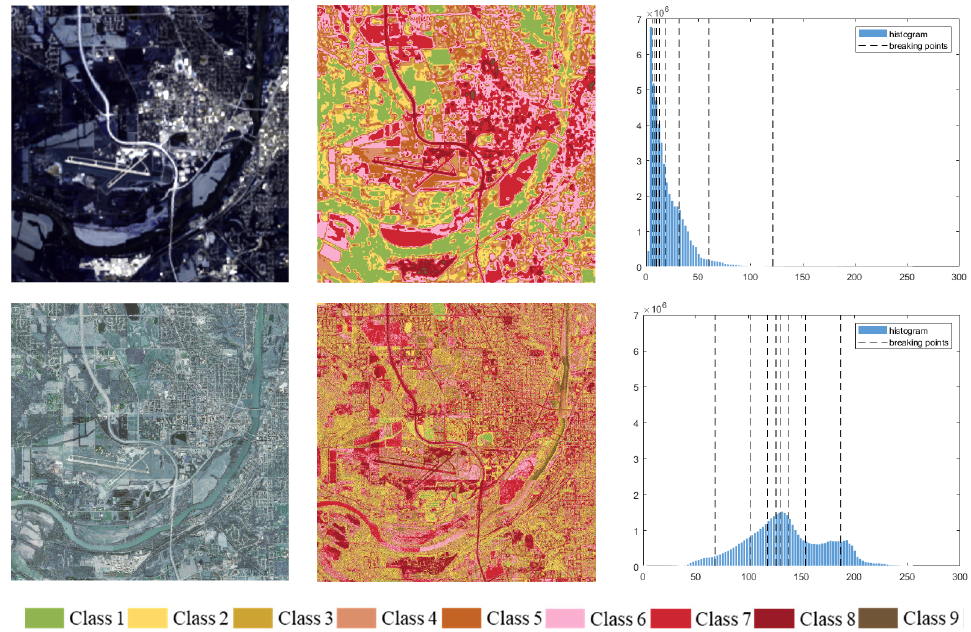
Figure 11. GIC classification results for the Landsat 8 image ( top ) and aerial RGB image ( bottom ) over the West Lafayette area. From left to right: RGB composite, classification result, and corresponding break points on the histograms.